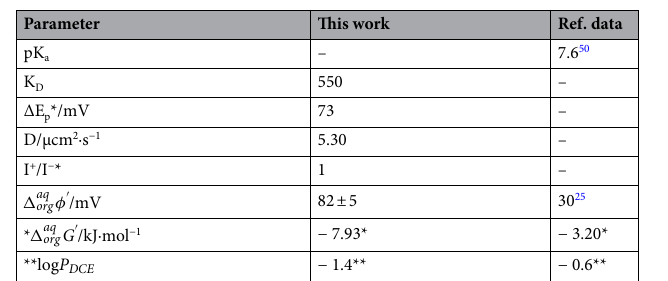
′ , where z and F is orgaq (cid:30) ′ ′ = − z · F · (cid:31) , where R (8.3145 J aq mol · K ) is the gas 2.303 · R · T org